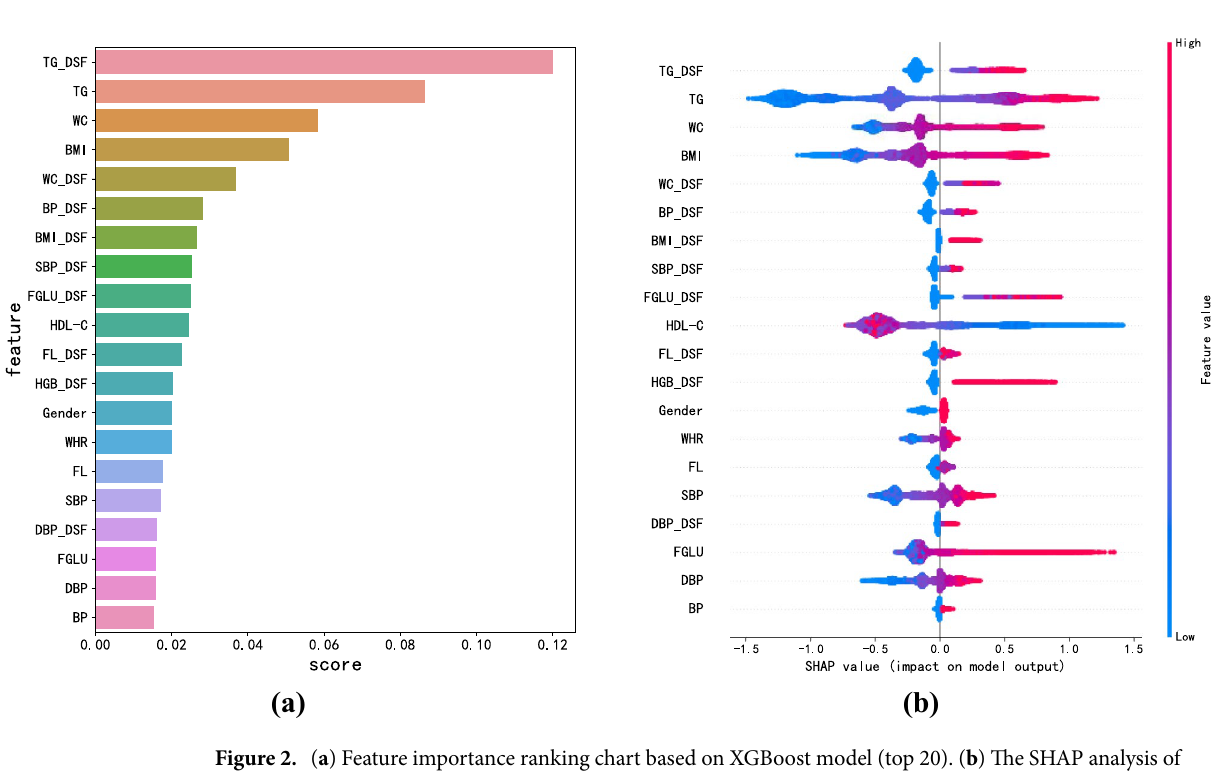
Figure 2. ( a ) Feature importance ranking chart based on XGBoost model (top 20). ( b ) The SHAP analysis of the important features. BMI_DSF, DSF of BMI; BP_DSF, DSF of BP; DBP, diastolic blood pressure; DBP_DSF, DSF of DBP; FGLU, fasting blood glucose; FGLU_DSF, DSF of FGLU; FL_DSF, DSF of FL; HGB_DSF, DSF of hemoglobin (HGB); SBP, systolic blood pressure; SBP_DSF, DSF of SBP; TG_DSF, DSF of TG; WC_DSF, DSF of